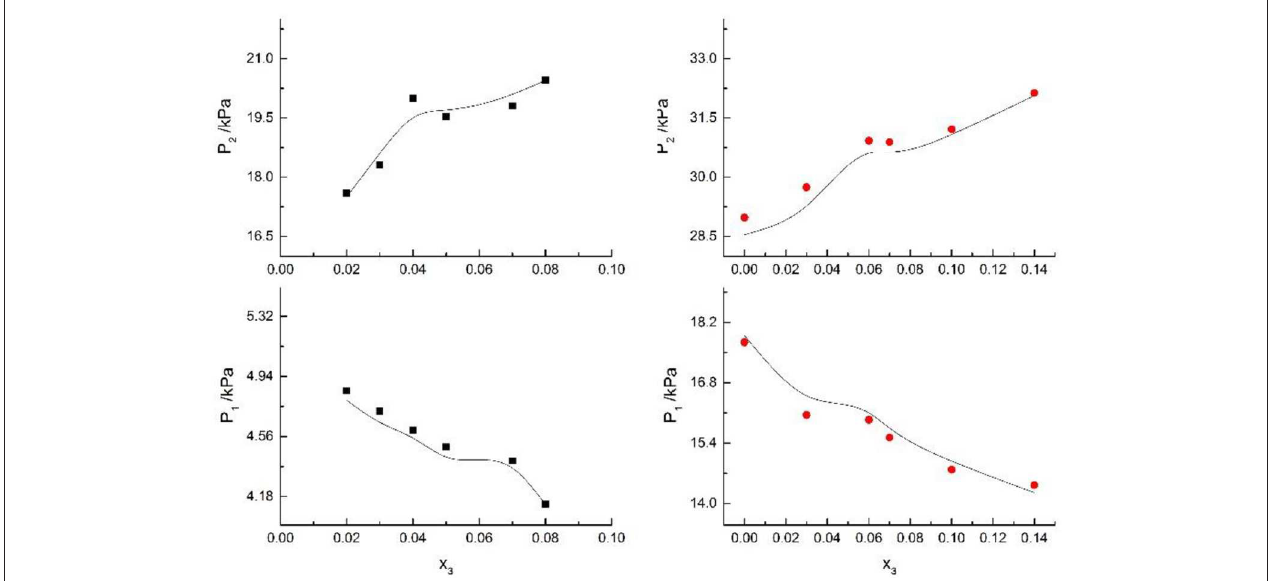
FIGURE 7 | Correlation of VLE data of H2O(1) + CH3OH(2) + NaI(3) system. Filled symbols ( (cid:4) x2 = 0.45 and T = 315K; • x2 = 0.22 and T = 335K) indicate experimental data; curves indicate correlation of the model.